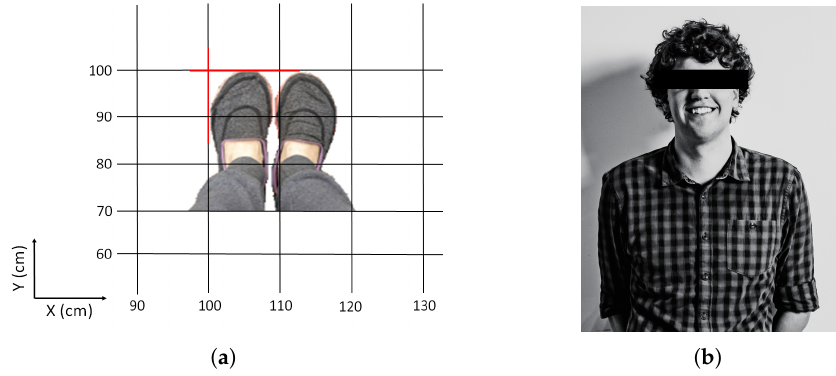
Figure 3. ( a ) Placement of the feet for location (100,100). ( b ) The test